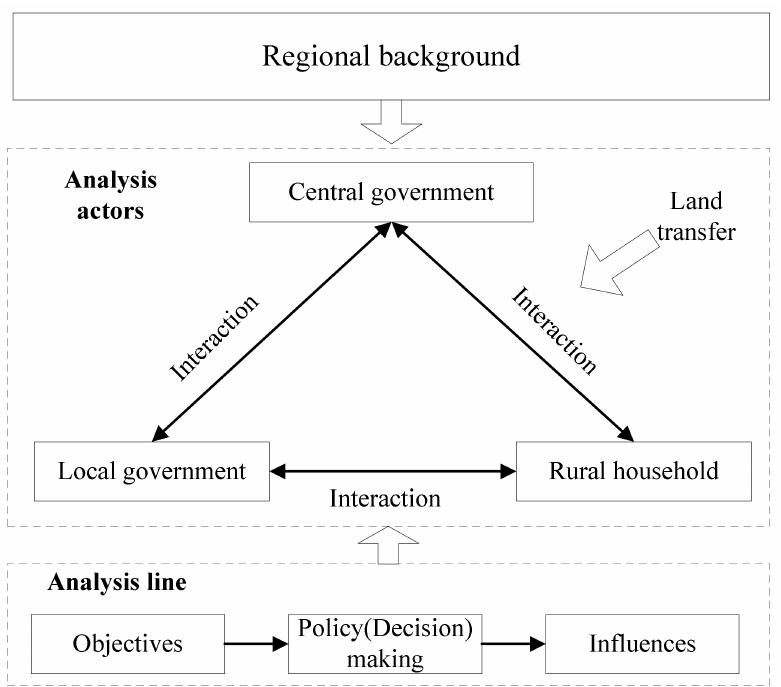
Figure 1. The research framework of the mechanism of cultivated land